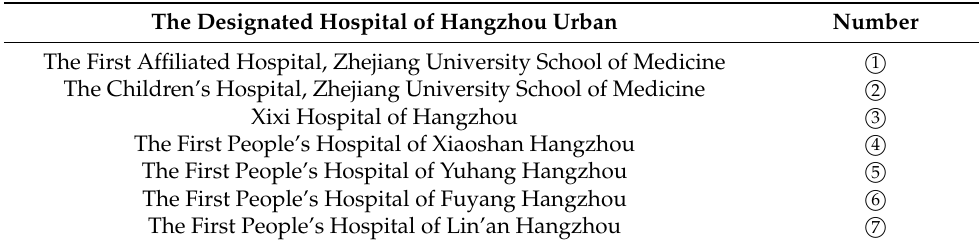
Table 6. Designated hospitals for COVID-19 treatment in Hangzhou